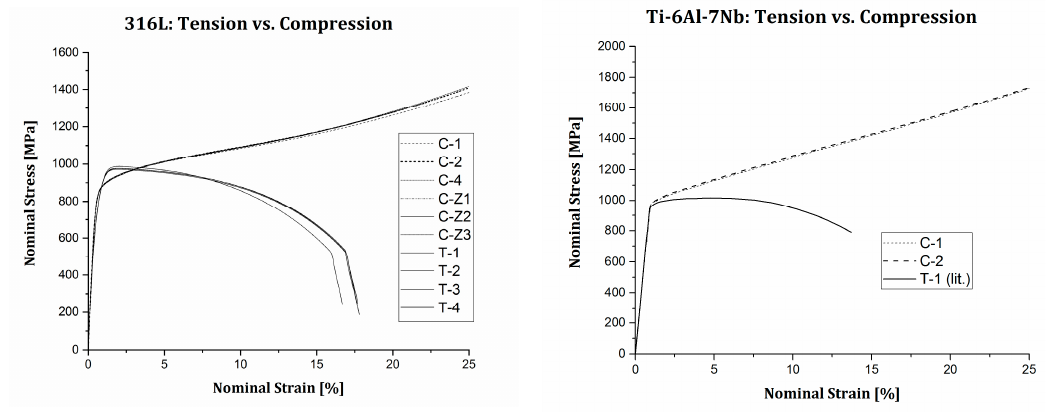
Figure 2. All test data, presented as nominal stress vs. nominal strain.